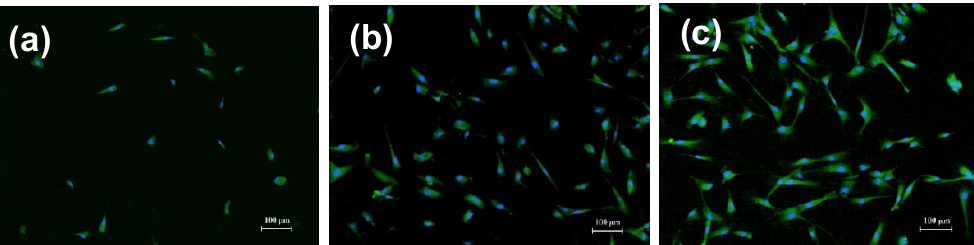
Figure 7. Fibroblasts on the surface of gel-based substrates. Cells were cultured for 96 h and fixed for fluorescent microscopy. Cell nuclei were stained with DAPI (4,6-diamidino-2-phenylindole), the cytoplasm was stained with pyrazolone yellow. ( a ) blank gel substrate; ( b ) gel-based substrate with 1.2% Al 2 O 3 nanoparticles; ( c ) gel-based substrate with 1.2% Fe 2 O 3 nanoparticles.